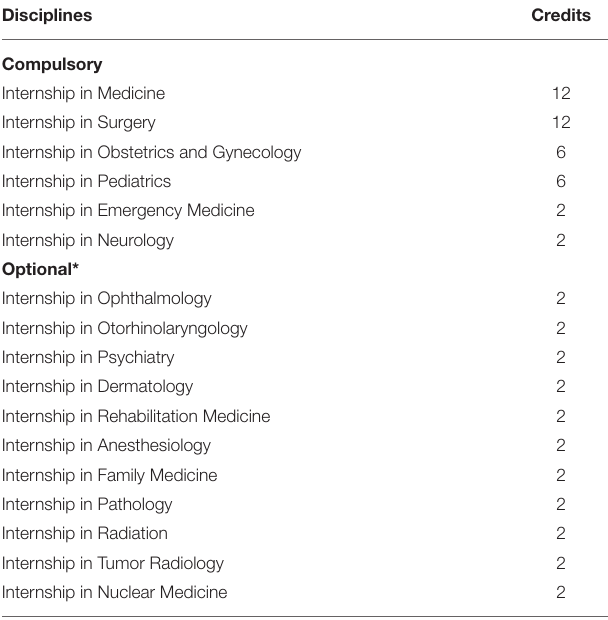
TABLE 1 | Credits and disciplines of ED internship